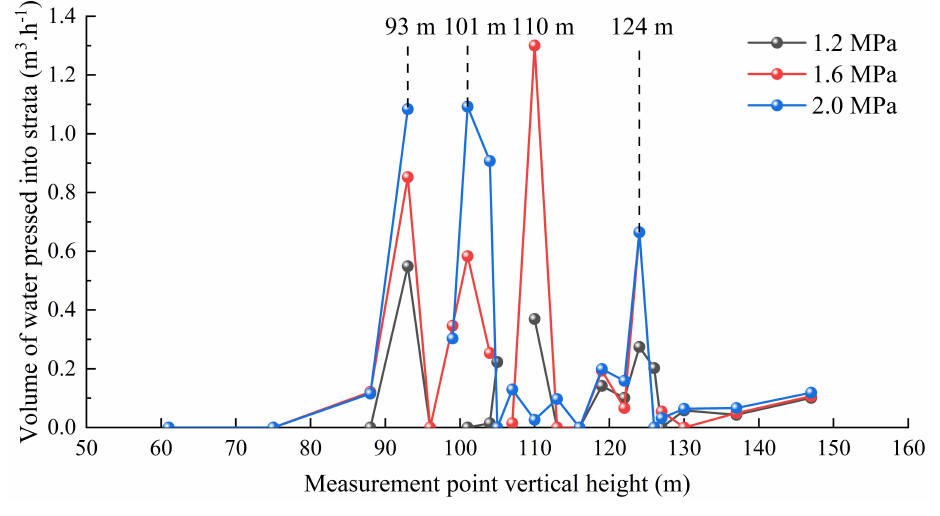
Figure 10. Water pressurized into the formation at different measuring points in T1.